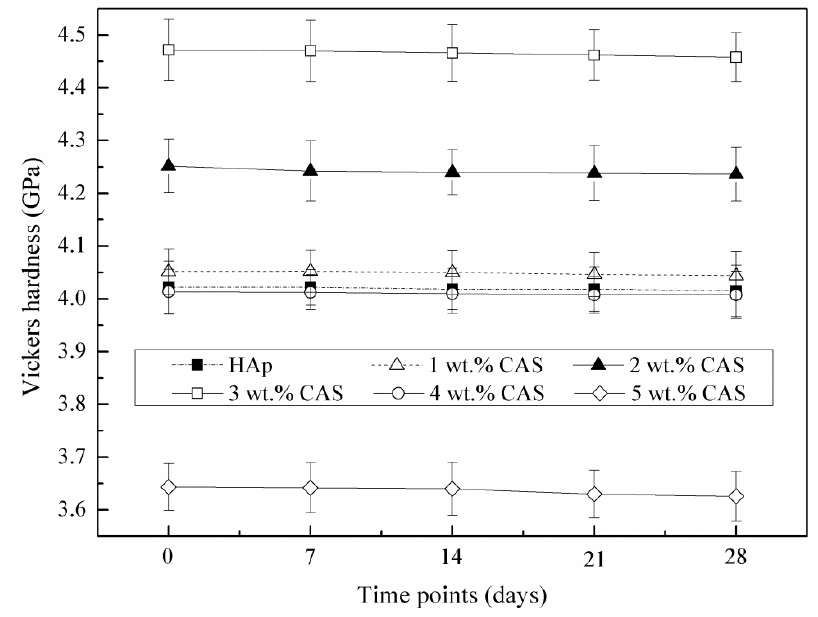
Figure 4. Vickers hardness of the HAp ceramics as a function of immersion time in simulated body fluid